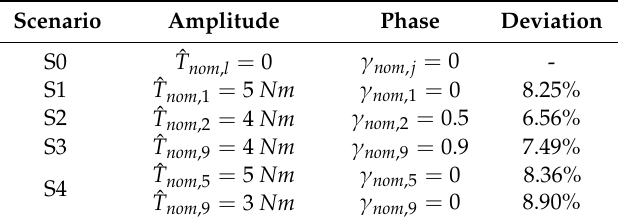
Figure 6. Order spectra of the time courses from Figure 5. For better representation, the bars for the zeroth order have been hidden and indicated by their numerical values.